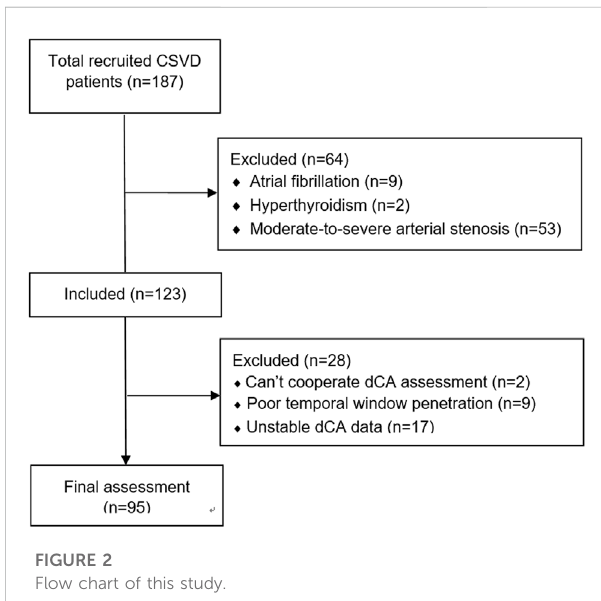
FIGURE 2 Flow chart of this